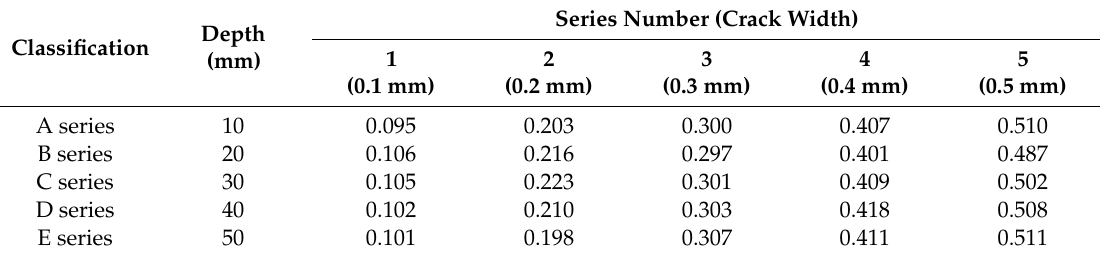
Table 1. Specimen